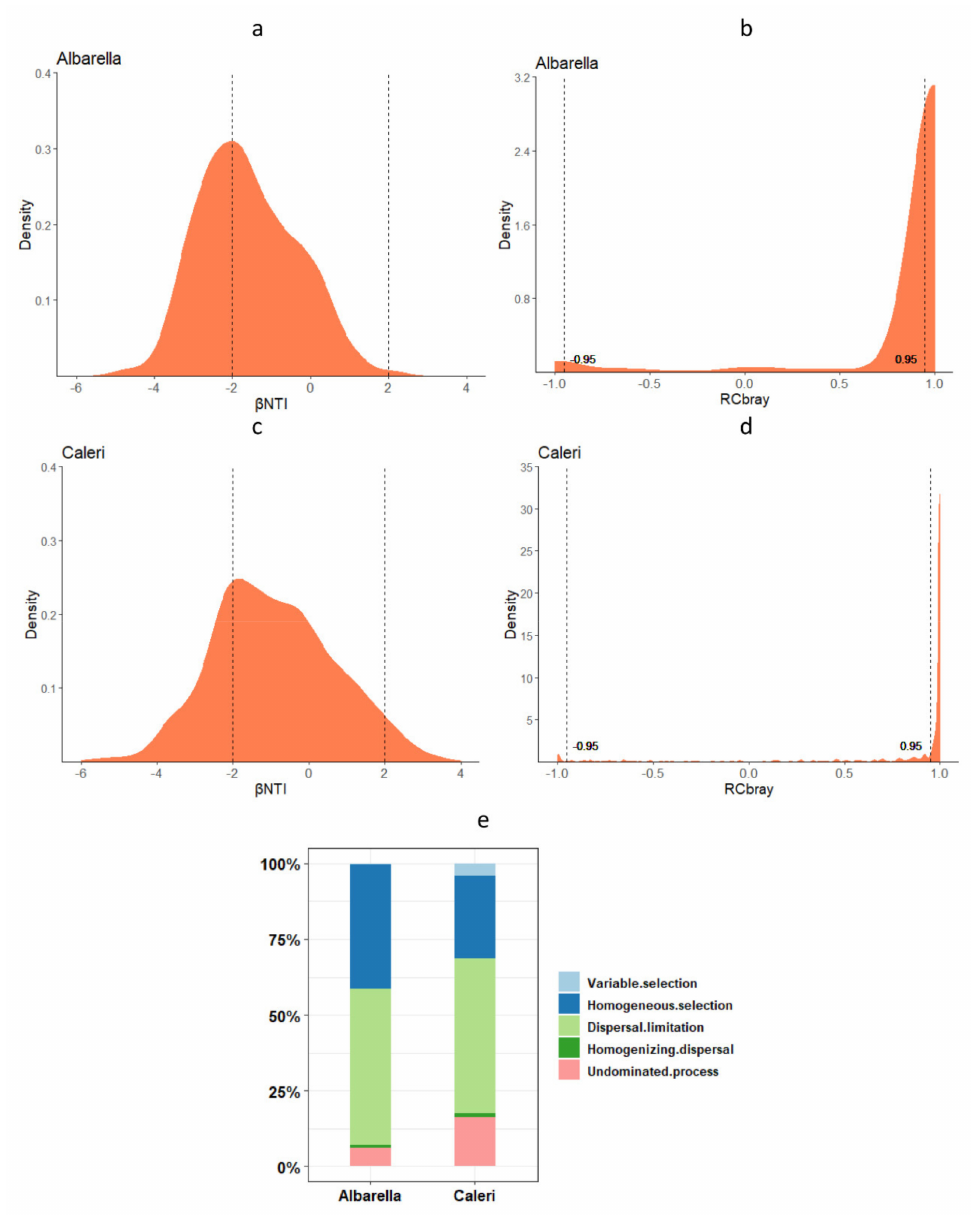
Figure 8. Distribution of standardized phylogenetic turnover and taxonomic turnover of soil fungi within Albarella and Caleri. ( a ): β NTI of Albarella, ( b ): RCBray of Albarella, ( c ): β NTI of Caleri, ( d ): RCBray of Caleri, ( e ): percentages of the five structuring processes in Albarella and